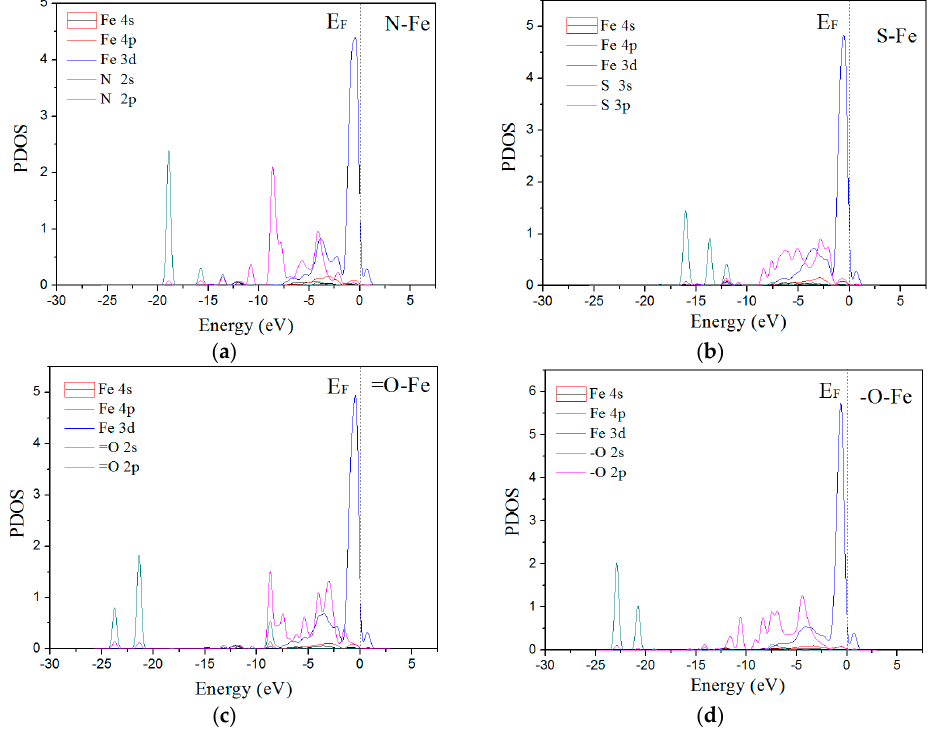
Figure 5. PDOS analysis for cysteine adsorbs on the pyrite (1 0 0), showing with -NH 3 ( a ), -SH ( b ), =O (-C=O, ( c )), -O (-C-OH, ( d )) of cysteine adsorbed on the Fe site of pyrite (1 0 0).